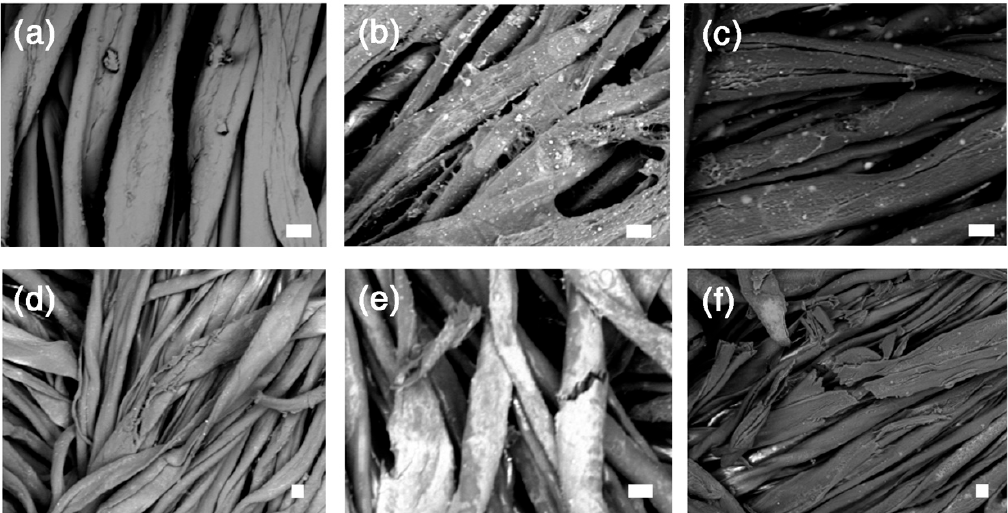
Figure 4. SEM images of samples belonging to the first set, before and after the artificial ageing. ( a ) T0 before ageing (1000 × magnification); ( b ) T1 before ageing (950 × magnification); ( c ) T3 before ageing (1000 × magnification); ( d ) T0 after ageing (500 × magnification); ( e ) T1 after ageing (1000 × magnification); ( f ) T3 after ageing (500 × magnification). The scale bar is 10 µm in all the images.